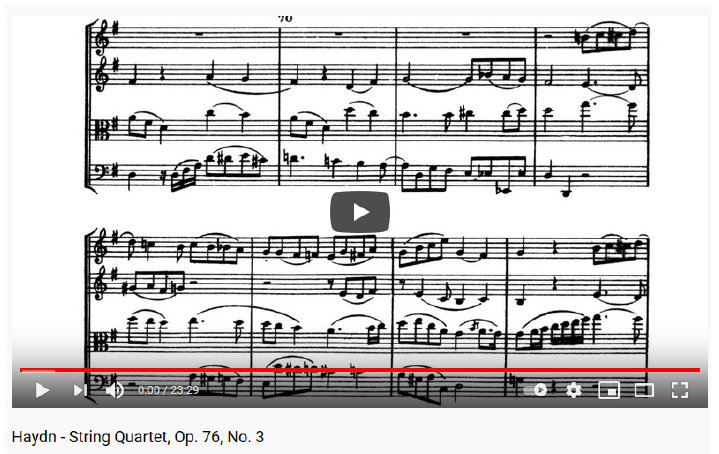
Figure 3. Slow movement from Haydn’s ‘Emperor’ quartet Opus 76, N ◦